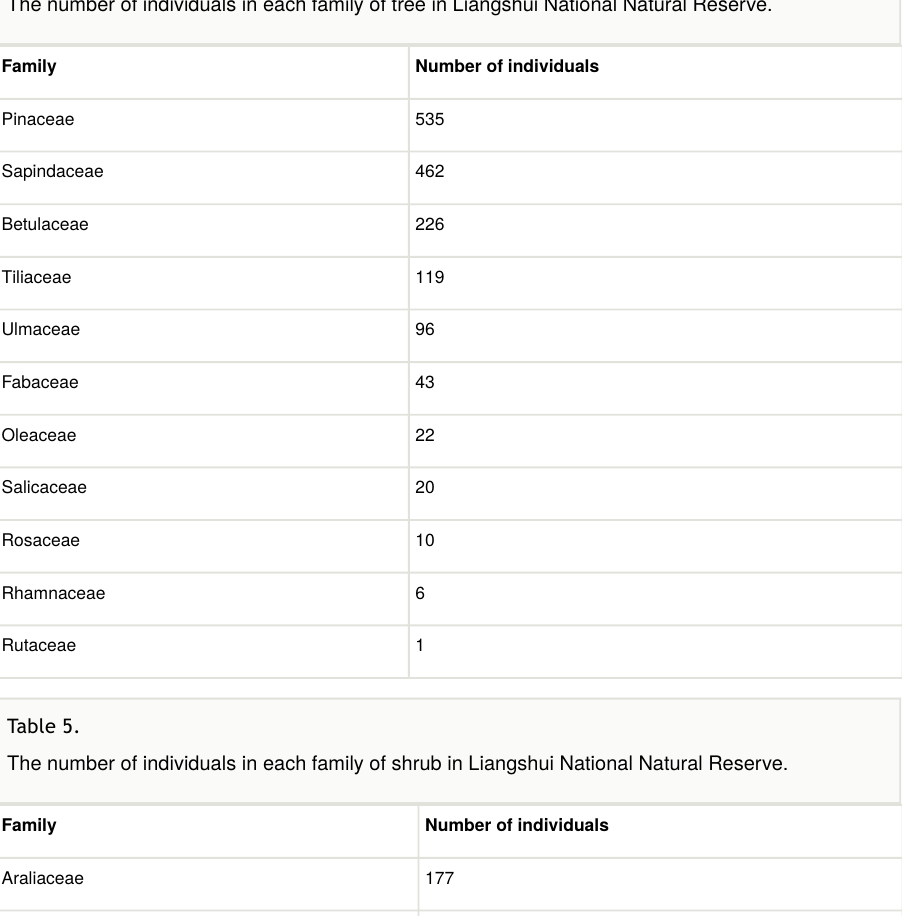
The number of individuals in each family of tree in Liangshui National Natural Reserve.